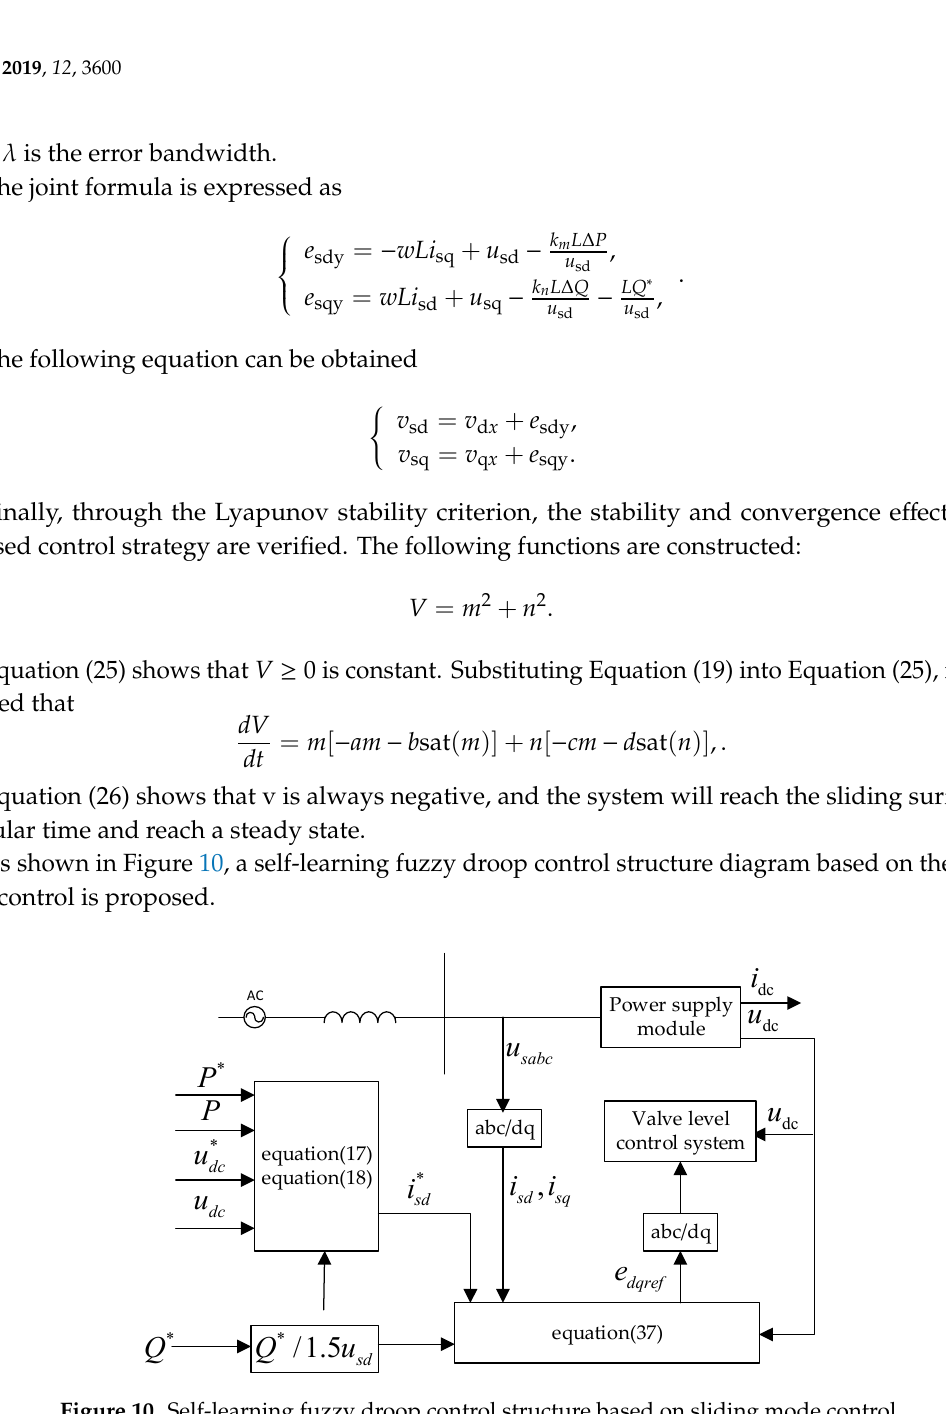
Figure 10. Self-learning fuzzy droop control structure based on sliding mode